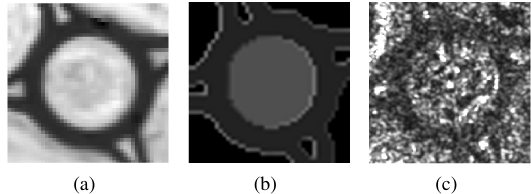
Figure 3: A roundabout in the optical image (a), the generated roundabout template (b) and the same roundabout in the SAR image (c).